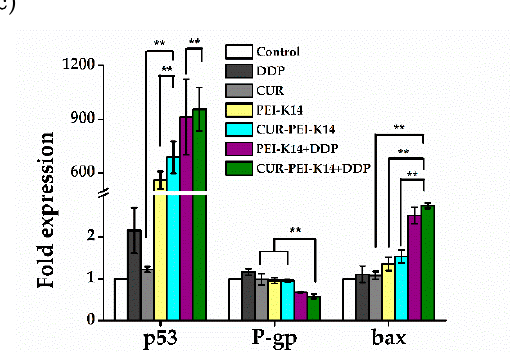
Figure 8. ( a ) Sensitizing e ff ect of CUR-PEI-K14 / p53 on DDP in SKOV3-DDP cells. ( b ) The cell inhibition rate of SKOV3-DDP cells in di ff erent administration modes. ( c ) Expression of p53, P-gp, and bax mRNA in SKOV3-DDP cells in di ff erent administration modes. Each data point represents the mean ± standard deviation ( n = 6, ** P < 0.01).